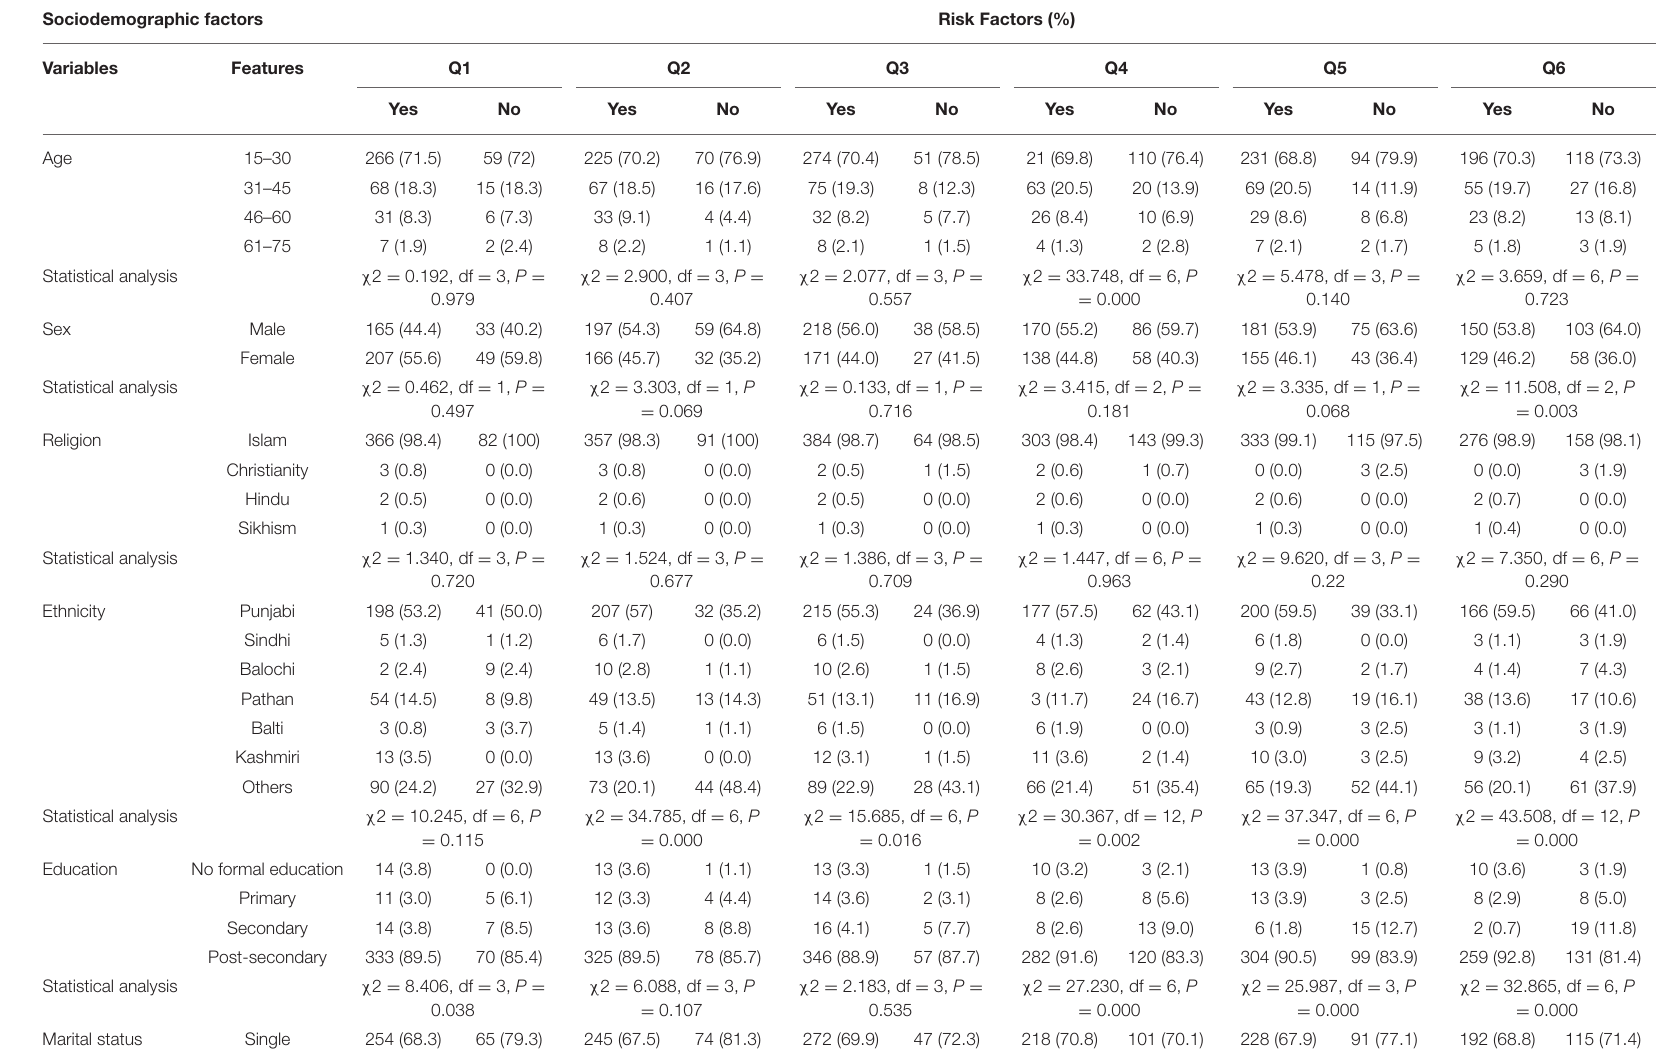
TABLE 7 | Representation of Sociodemographic factors based on risk factors of CE